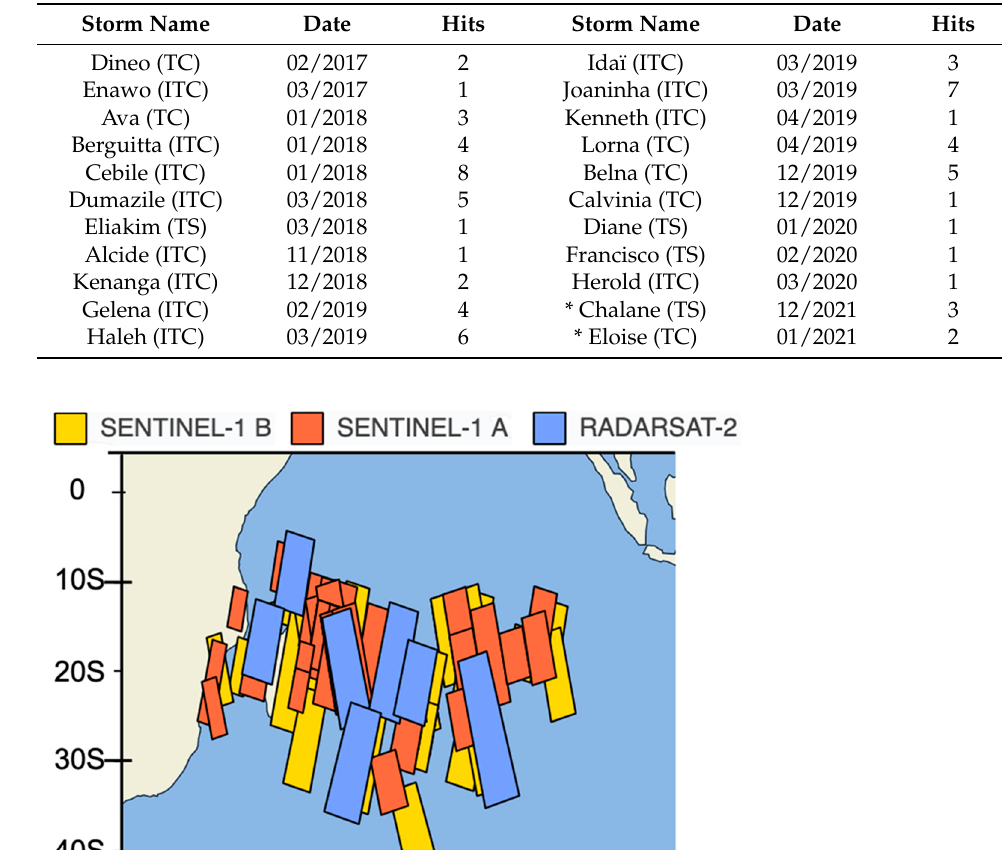
31 of 43 basin (Figure 23) at various storm evolution stages (cyclogenesis, intensification, dissipa- tion). Collected wind data were used for nowcasting and best-track data reanalysis pur- poses at RSMC La Réunion, model verification [33] and assimilation in NWP systems [125] (this Special Issue). Table 2. Number of Radarsat-2 and Sentinel-1 SAR acquisitions within the eyewall/eye (hits) of tropical storms (TSs) and tropical cyclones (TCs, ITC) that developed in the SWIO between February 2017 and 2021. * Acquisitions performed from 2021 onwards were made in the frame of the CYMS program (see Section 4).